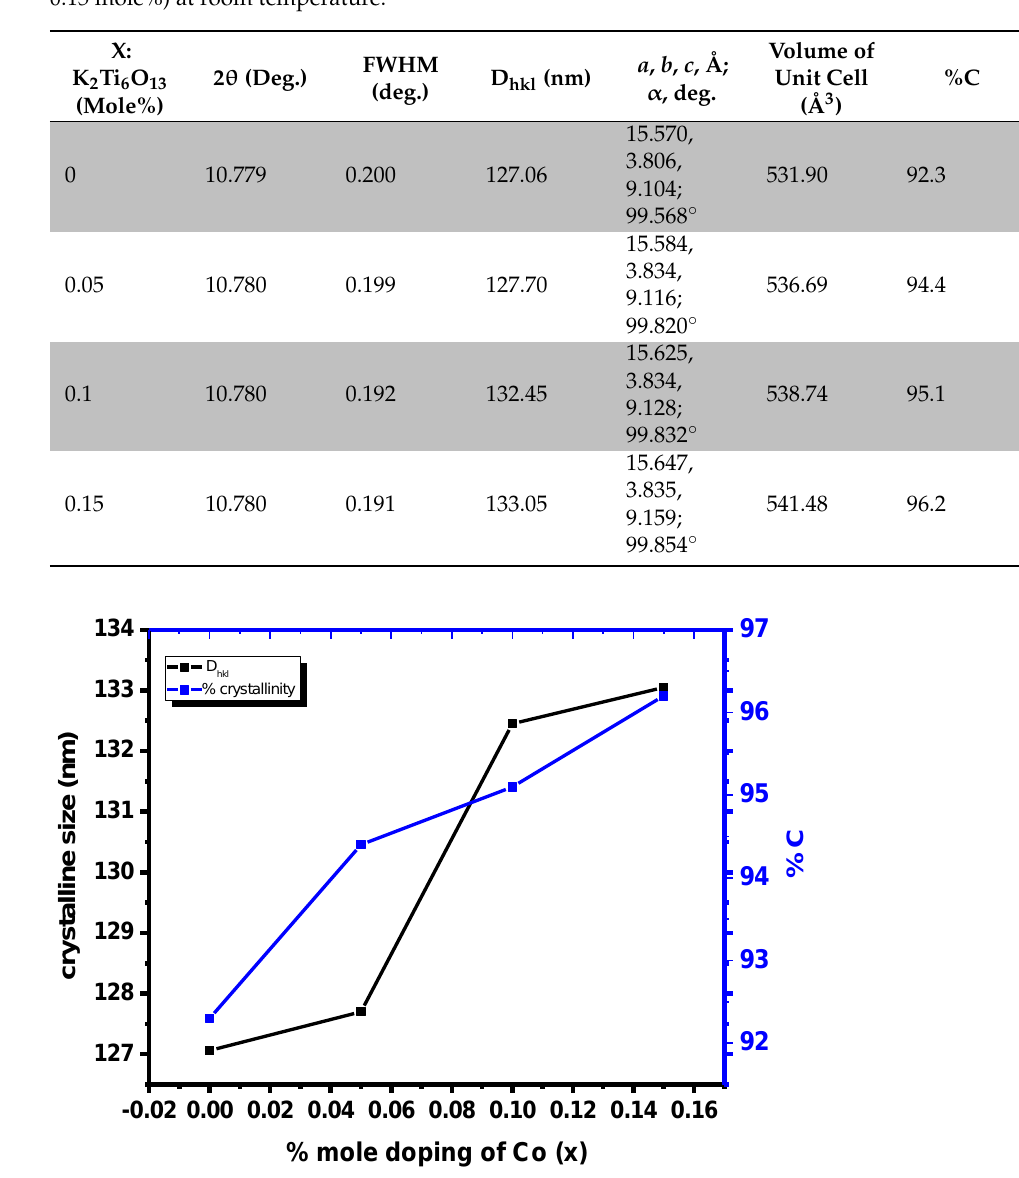
Figure 3. Crystallite size (D hkl ) and crystallinity (%C) variations with Co-doping in Co:K 2 Ti 6 O 13. Table 1. Various structural parameters of K 2 Ti 6 O 13 and Co x :K 2 Ti 6 O 13 ceramics (x = 0.0, 0.05, 0.1, and 0.15 % mole) at room temperature.